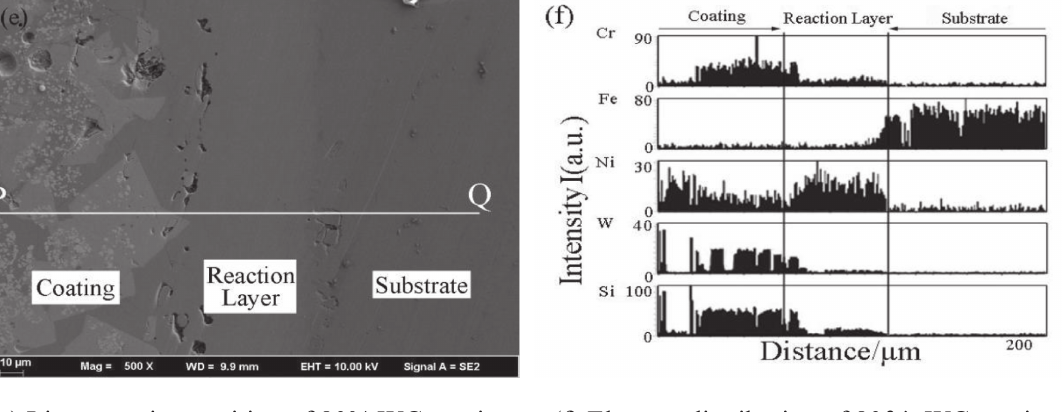
Figure 5: element distribution in brazed interface:(a) line scanning position of 30% WC coating, (b) element distribution of 30%WC coating, (c) line scanning position of 50% WC coating, (d) element distribution of 50 ％ WC coating, (e) line scanning position of 80% WC coating, (f) element distribution of 80 ％ WC